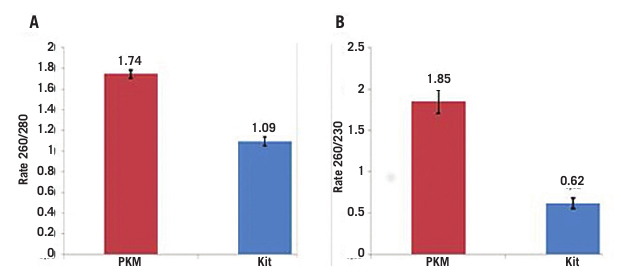
FigurE 2 − Ratios 260/280 (A) and 260/230 (B) in the methods used for extraction (* p < 0.05) PKM: proteinase K method.